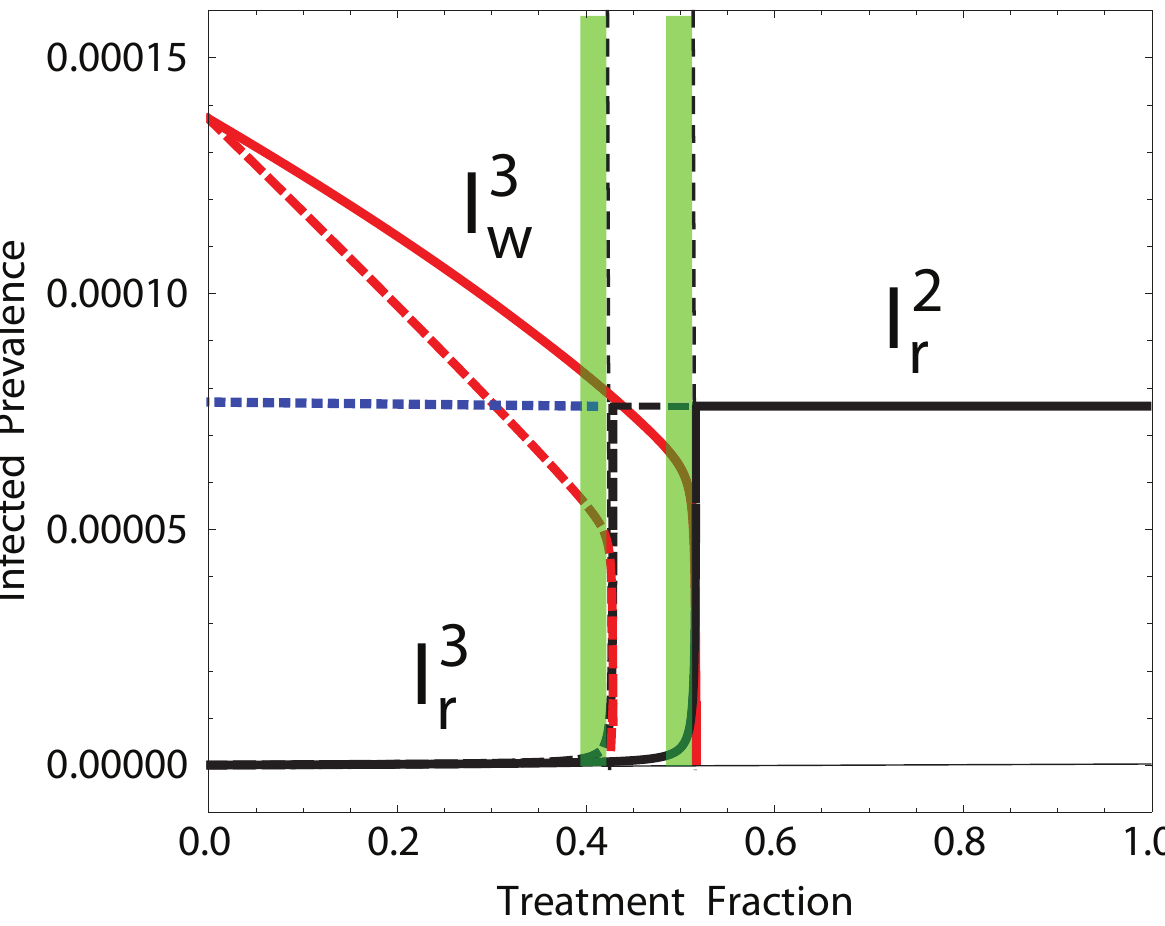
w ( 1 { r (cid:3) c ) { 1 . Prevalences I 2 and I 3 are depicted in black and I 3 in red, for two different r r w 0